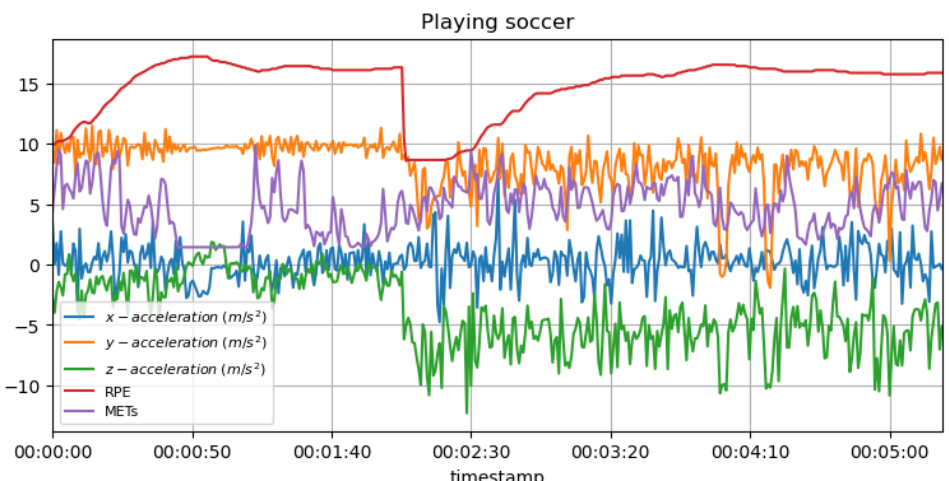
Figure 17. METs and RPE variations for football activity with acceleration data.